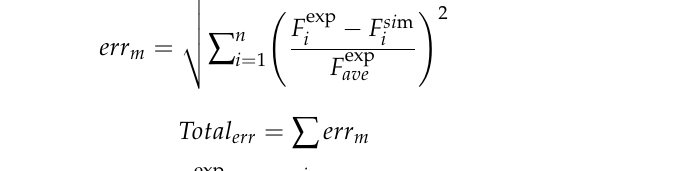
Figure 8. Error values predicted by P_Drucker yield function and von Mises yield function. 2 1